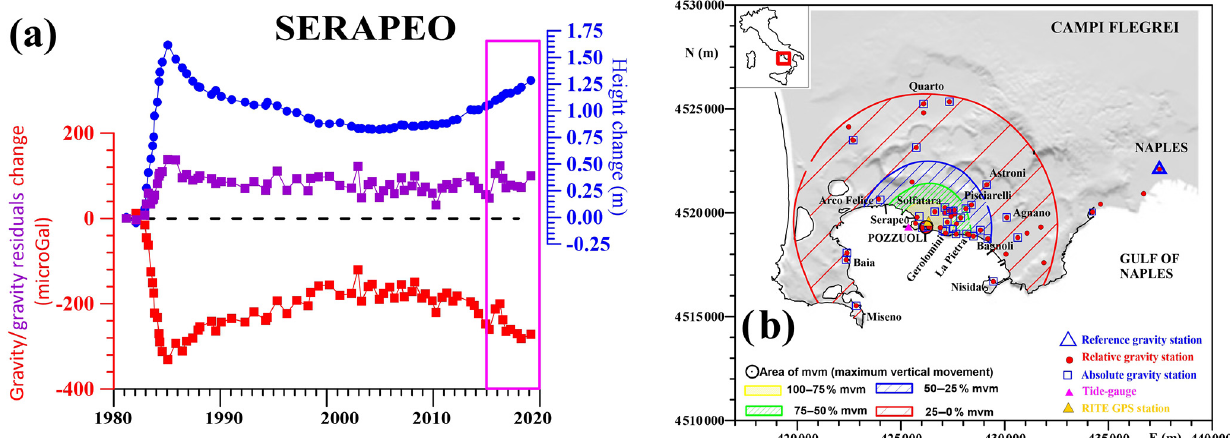
Figure 1. (a) Gravity (red full squares) and height (blue full points) changes from 1982 up today at the Serapeo station (see text for details) and related gravity residuals (violet full squares) after that the effect of the elevation changes have been subtracted. The pink rectangle highlightes the discussed time interval. (b) Present day relative (red full points) and absolute (blue open squares) gravity networks at the Campi Flegrei. The blue open triangle indicates the absolute gravity station in Naples that is the reference station for the relative network. The pink and yellow triangles in Pozzuoli (along the coast in the center of the caldera) respectively indicate the tide-gauge in Pozzuoli Harbor and the RITE permanent GPS station. The hatched concentric circles show the schematic representation of the vertical ground movements pattern (see text for details). The area is divided into four sub-areas represented in terms of percentage of the maximum vertical deformation (mvm) occurring in the center of the caldera and indicated with a black open